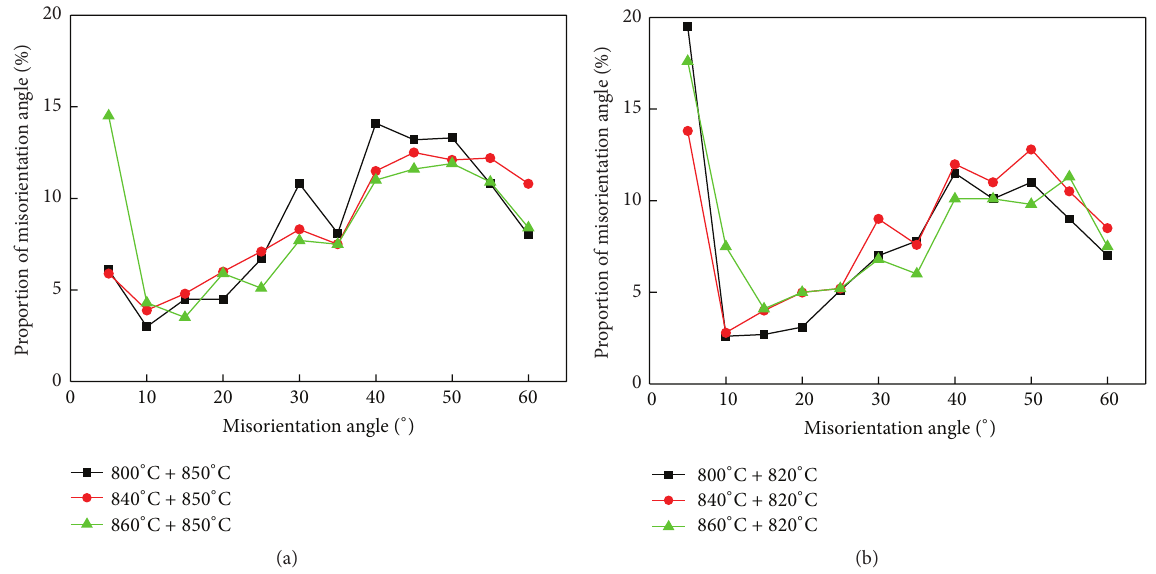
Figure 5: Misorientation distribution under different intermediate annealing temperatures: (a) test group of samples intermediately annealed at 850 ∘ C; (b) test group of samples intermediately annealed at 820 ∘ C.